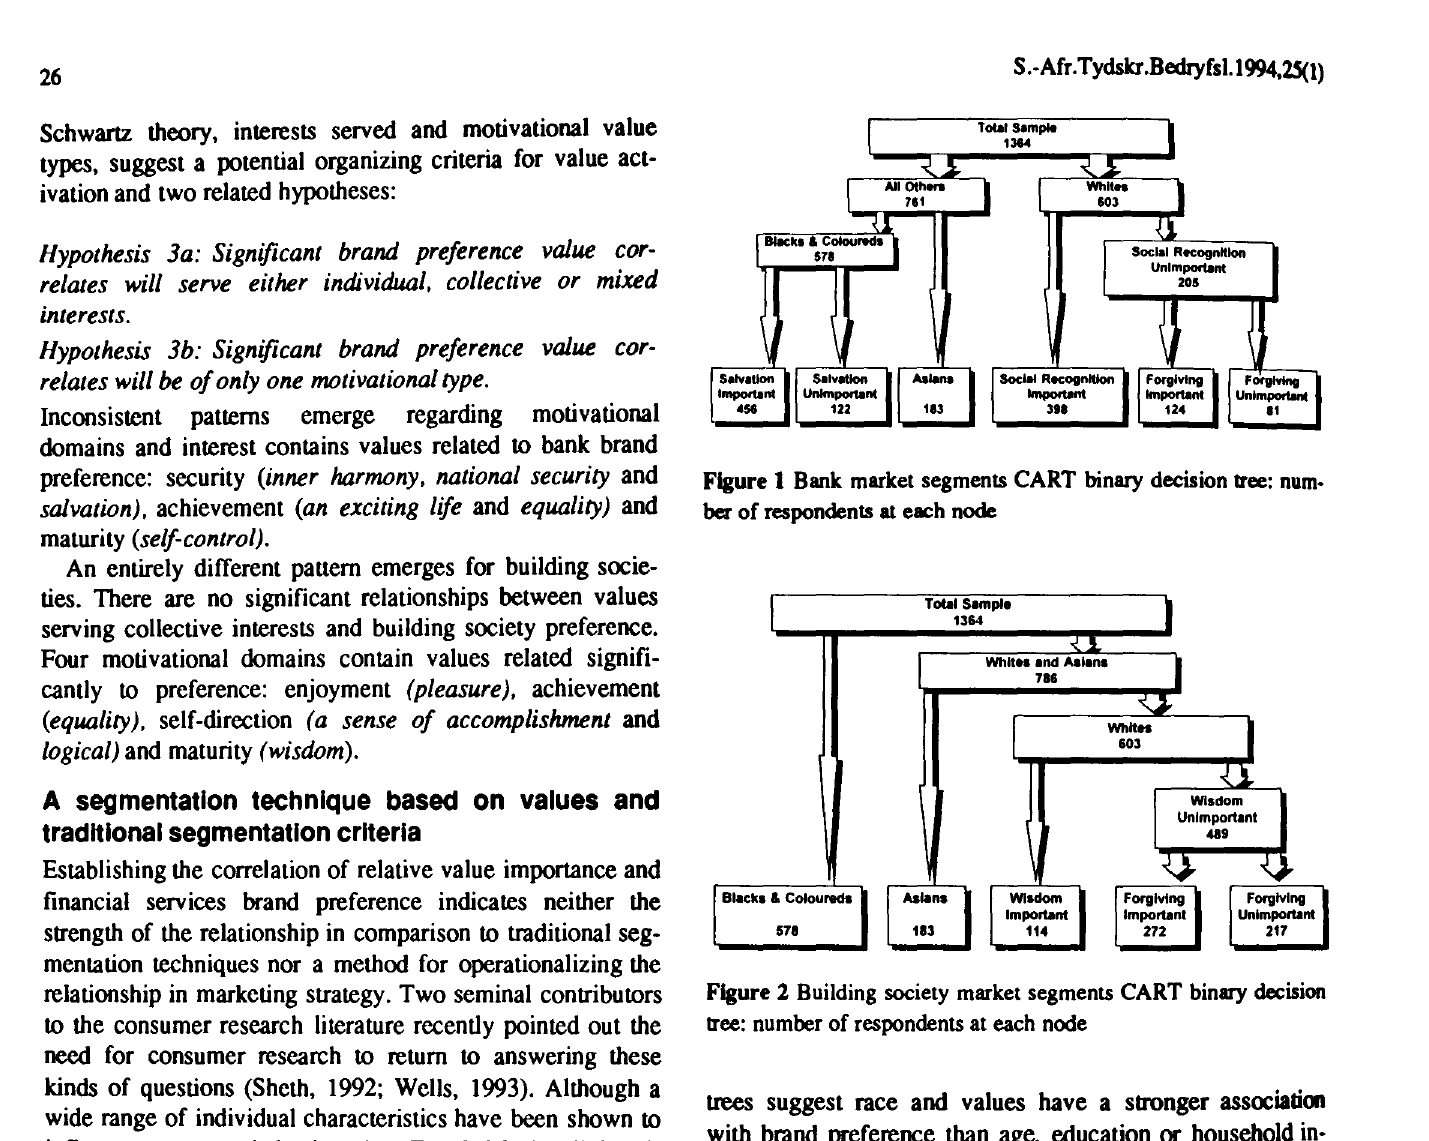
Figure 2 Building society market segments CART binary decision tree: number of respondents at each node